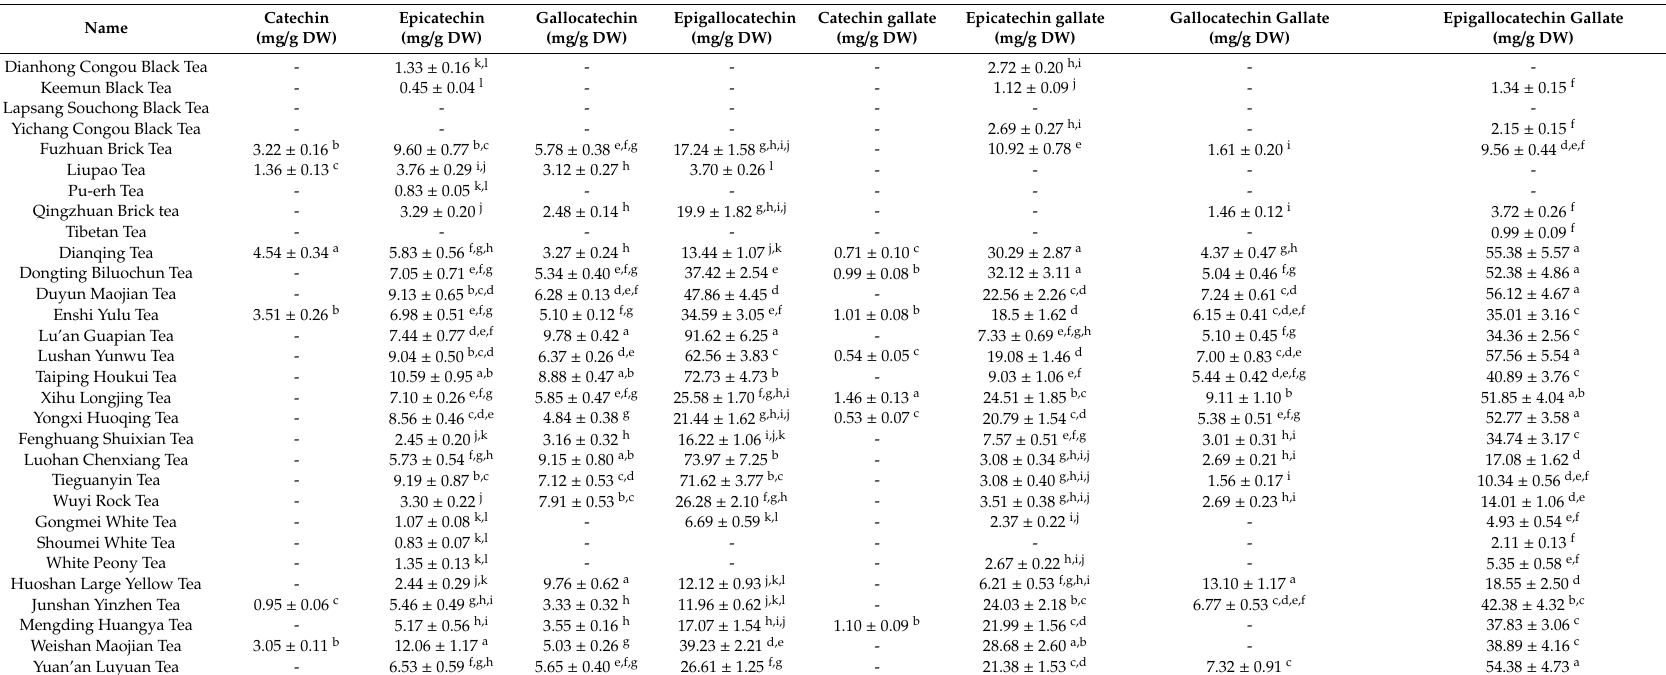
Table 2. The contents of phenolic compounds and ca ff eine in 30